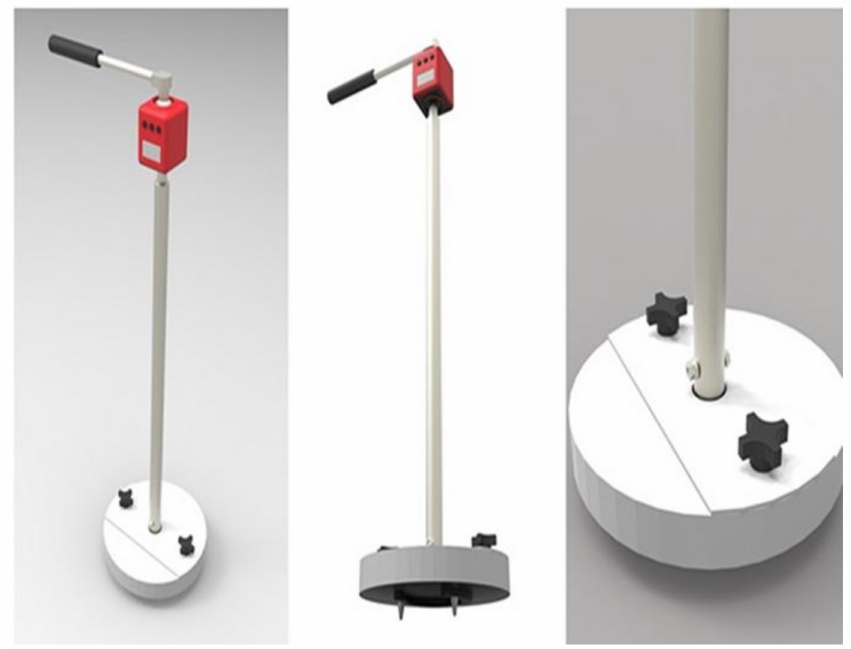
Figure 6. The rotational traction tester based on a device used for playing fields (ASTM F2333-04).